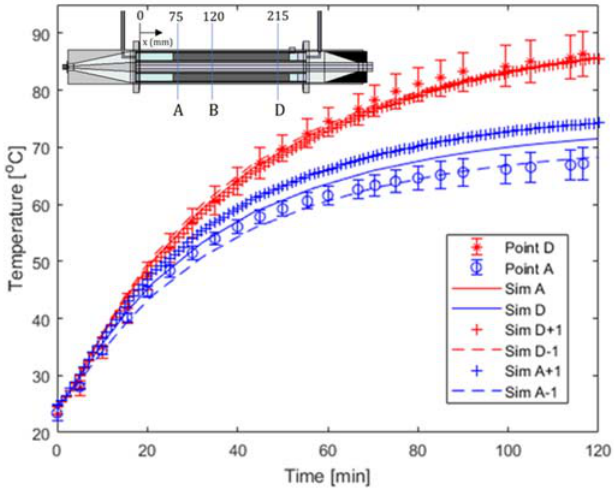
Figure 4. Comparison of the experimental and simulated transient temperatures in the crushed α -SiC foam under 60 W microwave power input ( A and D are the locations of the